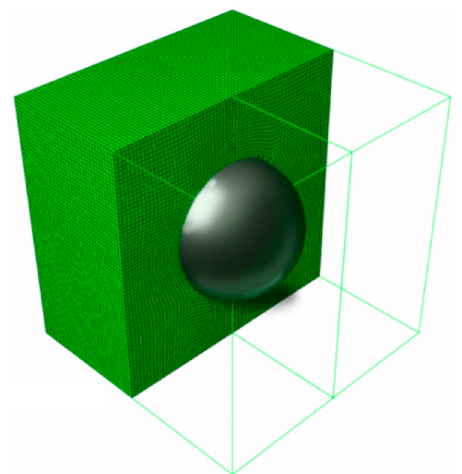
Figure 2. Representative volume element (RVE) of the composite.